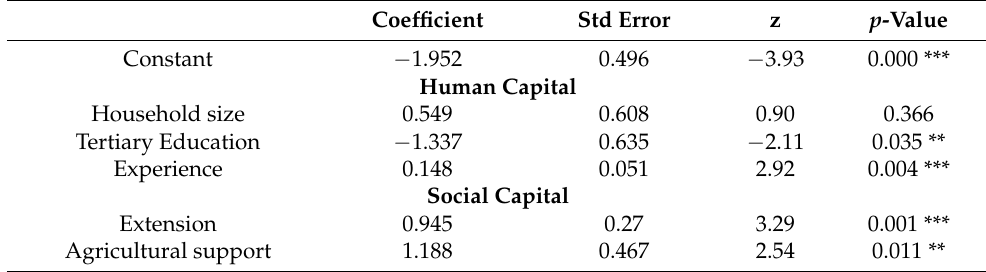
Table 4. Estimated parameters for the probit